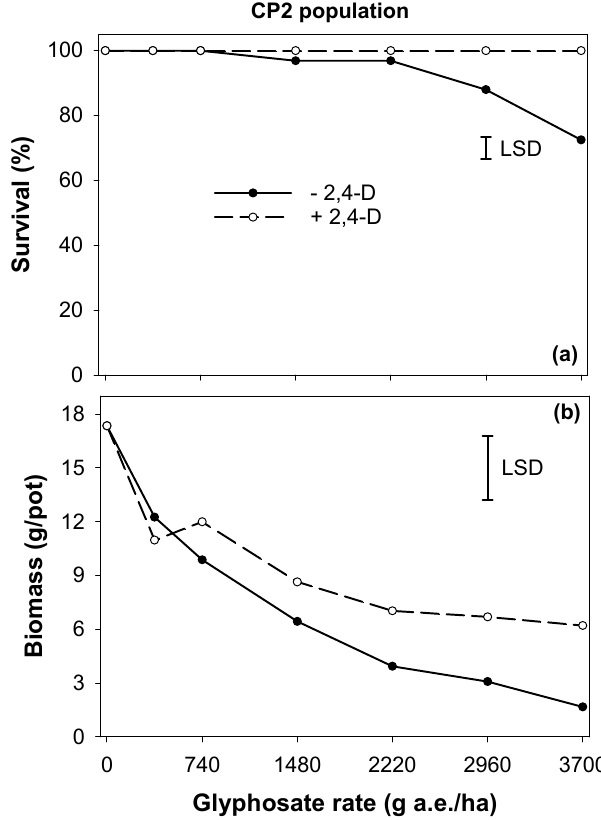
Figure 4. The antagonistic effect of 2,4-D on glyphosate efficacy for the CP2 population of Chloris virgata in terms of ( a ) survival (%) and ( b ) biomass (g pot − 1 ); LSD: least significant difference at the 5% level.